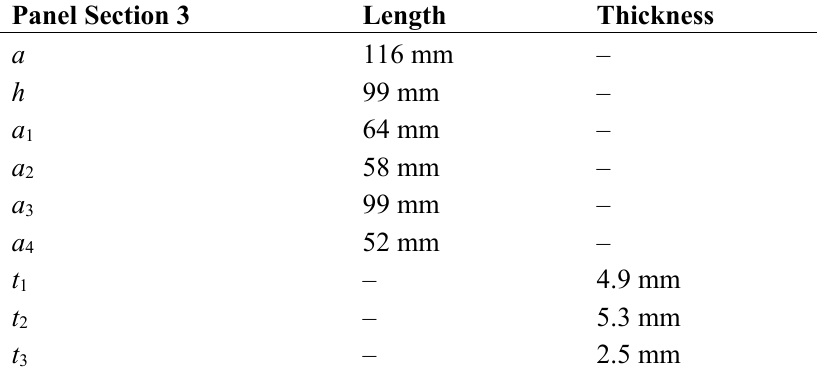
Table 8. Dimensions of optimized Panel Section 4 (see Figure 2 for an explanation).